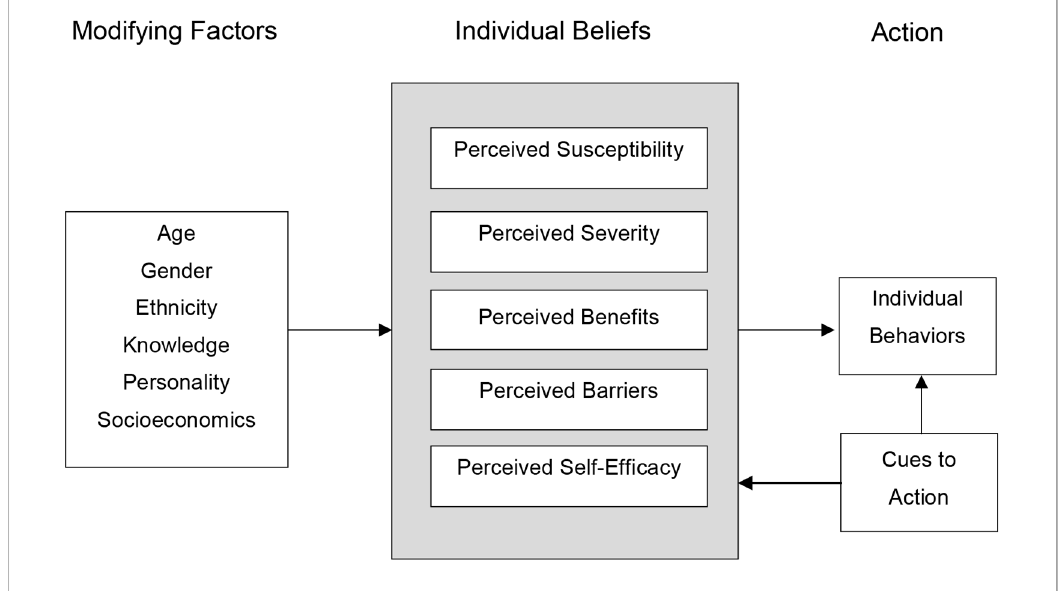
Figure 1. General components of the Health Belief Model (HBM). The HBM is a widely applied health behavior framework that can be used to explain and theorize areas to target in communication interventions. Source: Adapted from Glanz et al., 2015.